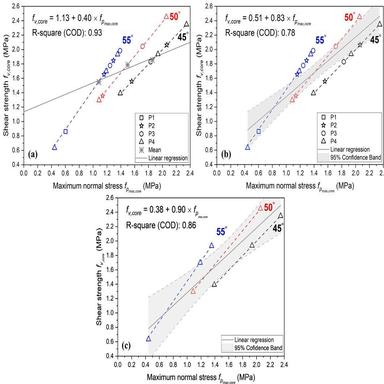
Failure envelope from splitting tests on cores using: (a) the average result for each inclination; (b) all data from P1 to P4; (c) all data from P4.